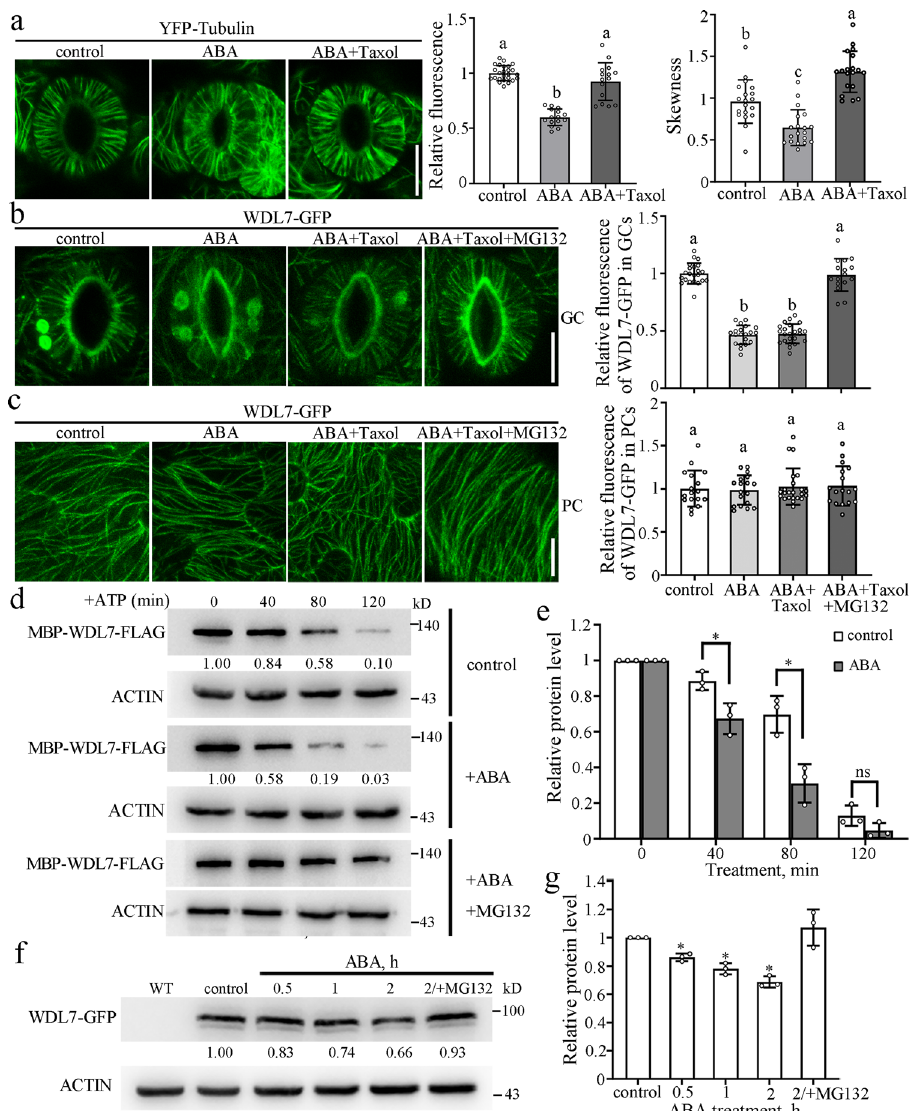
Fig. 2 WDL7 is degraded during ABA-induced stomatal closure. a Detached rosette leaves from YFP-tubulin were incubated in opening buffer for 2 h and then treated with 10 μ M ABA plus 0 or 20 μ M Taxol for 40 min. Scale bar = 10 μ m. The graphs show the relative fl uorescence of YFP-tubulin and quantitative analysis of microtubule bundling (skewness). Data represent mean ± standard deviation (SD) values from three independent experiments with a minimum of 15 cells each. Different letters represent signi fi cant differences at p < 0.01 (one-way ANOVA). b , c Detached rosette leaves from WDL7-GFP transgenic seedlings were incubated in opening buffer for 2 h and then treated with 10 μ M ABA, 10 μ M ABA plus 20 μ M Taxol, 10 μ M ABA plus 20 μ M Taxol and 50 μ M MG132 for 40 min. Confocal images of the guard cells and pavement cells were taken. Scale bar = 10 μ m. The graph shows the relative fl uorescence of WDL7-GFP in b and c . Data represent mean ± standard deviation (SD) values from three independent experiments with a minimum of 15 cells each. Different letters represent signi fi cant differences at p < 0.01 (one-way ANOVA). d Ten-day-old WT seedlings were treated with mock buffer, 10 μ M ABA, or 10 μ M ABA plus 50 μ M MG132 for 1 h and then total proteins were extracted. Puri fi ed MBP-WDL7-FLAG was incubated with equal amount of total proteins for the indicated times. MBP-WDL7-FLAG was detected with anti-FLAG antibody. Actin was used as a control. e Quantitative analysis of protein levels in d . The WDL7 protein level at 0 h was set to 1 as a reference for calculating the relative protein levels at the various time points. Data represent the mean ± SD for three independent experiments. Two-tailed Student ’ s t test, * p < 0.05. f Ten-day-old WDL7-GFP transgenic seedlings were treated with mock buffer, 10 μ M ABA, or 10 μ M ABA plus 50 μ M MG132 for indicated times and then total proteins were extracted from the leaves. WDL7- GFP was detected with anti-GFP antibody. Actin was used as a control. g Quantitative analysis of protein levels in f . The protein level of WDL7-GFP treated with mock buffer was set to 1 as a reference for calculating relative protein levels of various time points. Data represent the mean ± SD for three independent experiments. Two-tailed Student ’ s t test, * p <